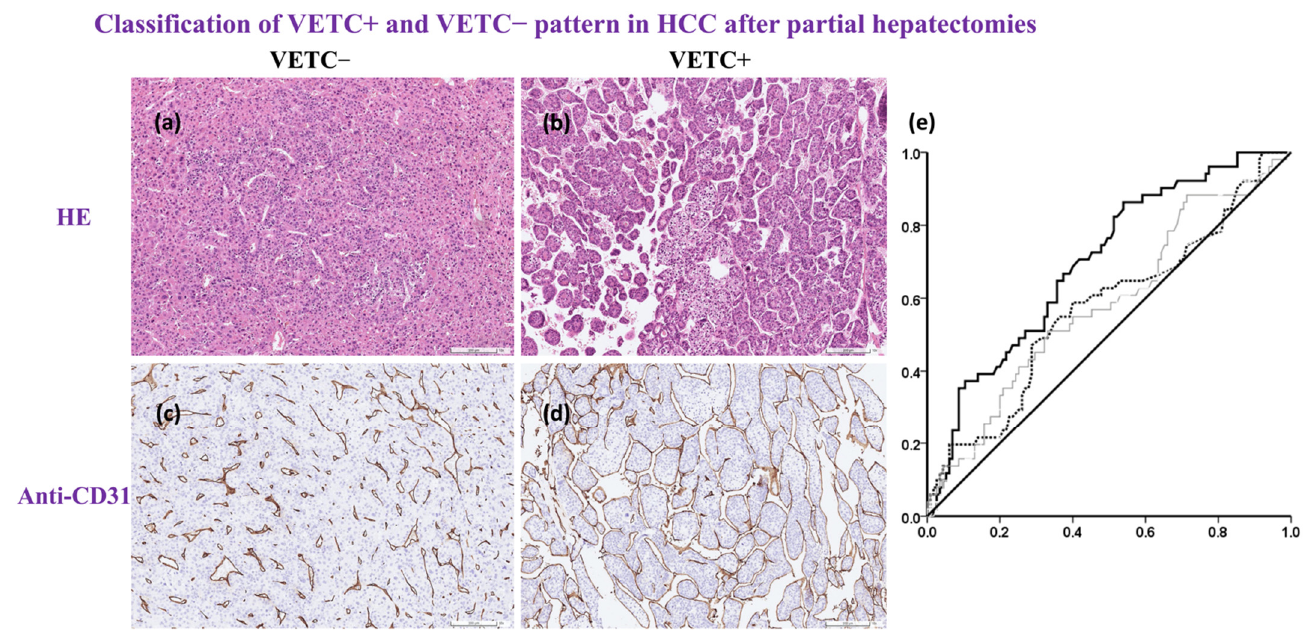
Figure 2. Histological photo based on Hematoxylin & Eosin stain or Anti-CD31; ROC curves for predicting VETC + . All surgical specimens were sent to and processed by a qualified pathologist. ( a , b ), H&E staining is the gold standard for medical diagnosis. Hypercellular density was noted in the VETC + group, but the vascular structure was not clear on the H&E stain. ( c , d ), special anti-CD31 stain for the evaluation of intra-tumoral endothelial cells. The number of CD31-positive vessels/mm 2 indicated intra-tumoral MVD. There were two distinct vascular patterns: ( c ), capillary-like vessels and disconnected blood vessels with small or no lumen indicated VETC − ; ( d ) vessels that encapsulated tumor clusters and formed a cobweb-like pattern indicated VETC + ; scale bar, 100 μ m. ( e ) ROC curves for predicting VETC + according to intra-tumoral MVD, the MVD of the normal part of the liver, and serum α -fetoprotein (black line, dotted line and grey line, respectively). Only intra-tumoral MVD independently predicted VETC + (AUROC = 0.693; 95% CI, 0.613 to 0.780, p < 0.001). When the cut-off score was 40 vessels/mm 2 , the sensitivity and specificity of VETC + was 0.863 and 0.461, respectively. Anti-CD31, cluster of differentiation 31 antibody; ROC curve, receiver operating characteristic curve; VETC + , positive VETC pattern; H&E stain, Hematoxylin & Eosin stain; MVD. Microvessel density; VETC − , negative VETC pattern, AFP, α -fetoprotein; Intra-tumoral MVD, black line; Normal part liver MVD, dotted line; Serum AFP, grey line.